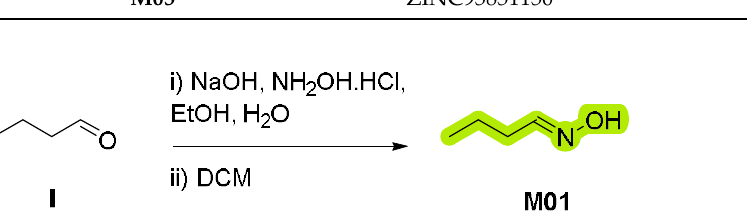
Figure 11. Synthetic route for the preparation of M01 . DCM (dichloromethane). Starting material I is commercially available.